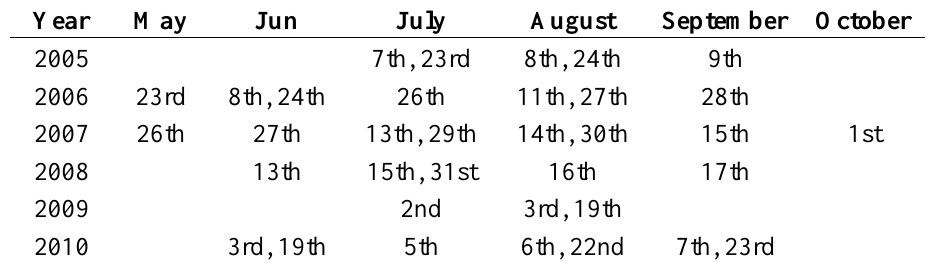
Figure 1. Validation site of Jalapão in the state of Tocantins. The Cerrado biome is delimited in gray. Table 1. Dates of Landsat images that were used to derive reference maps of burned